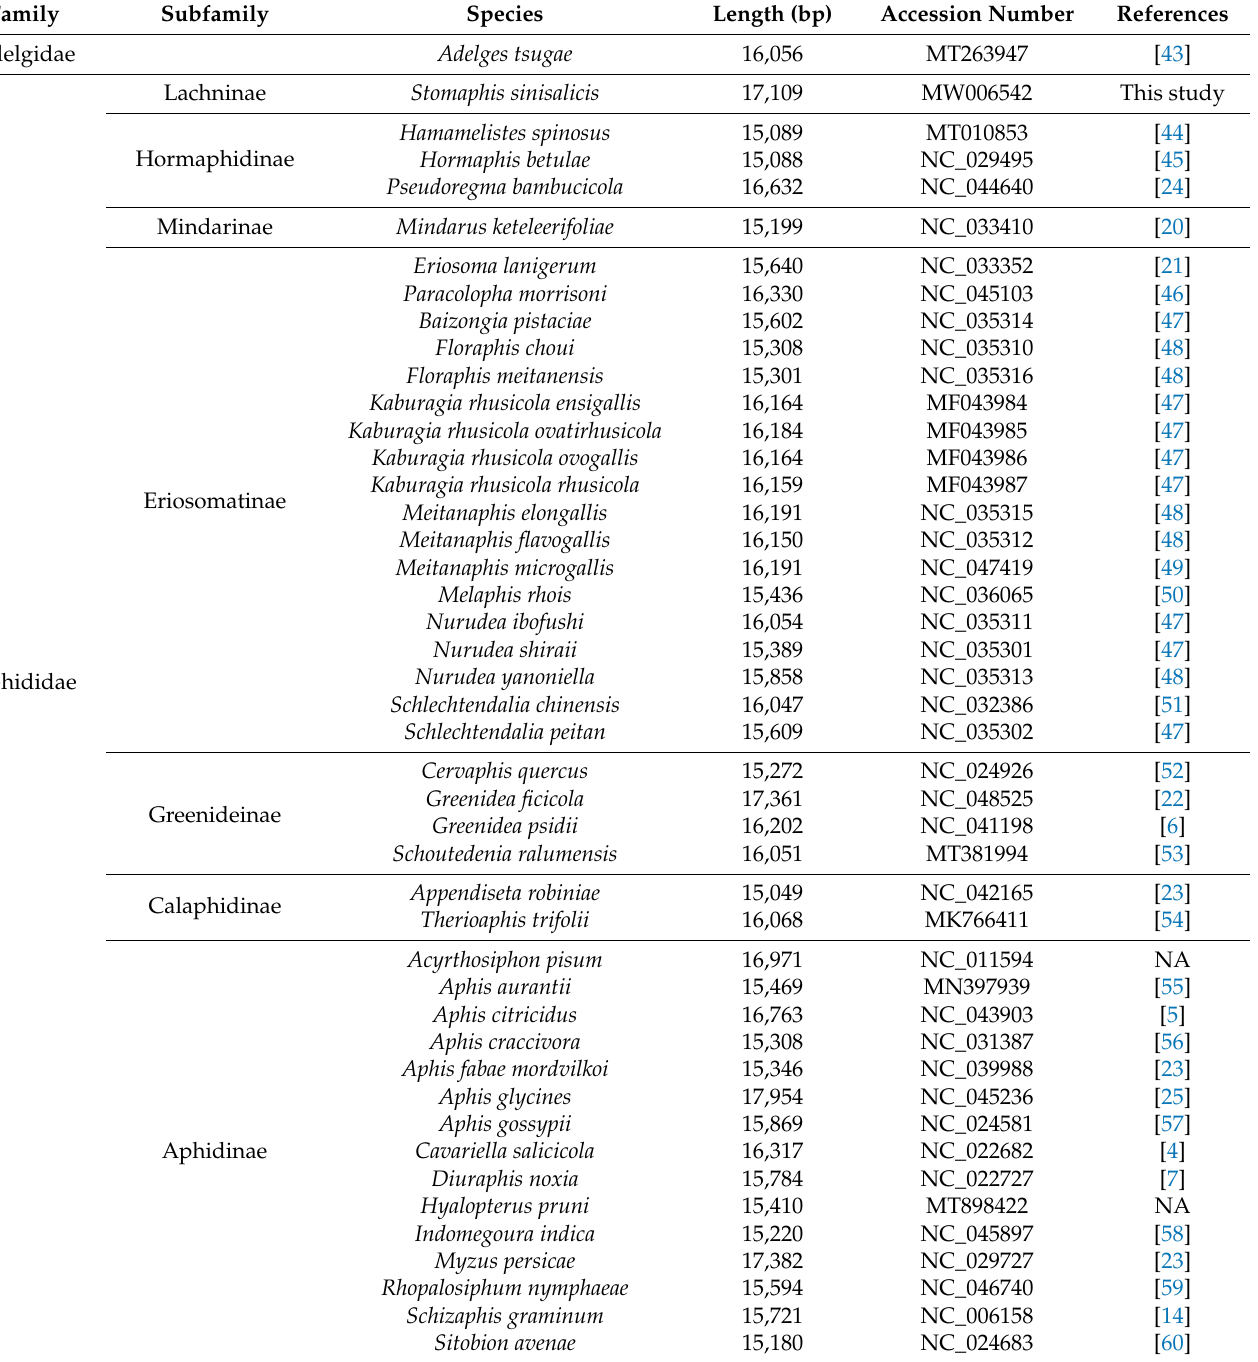
Table 1. Information for representative complete mitochondrial genomes of aphids used in this study.